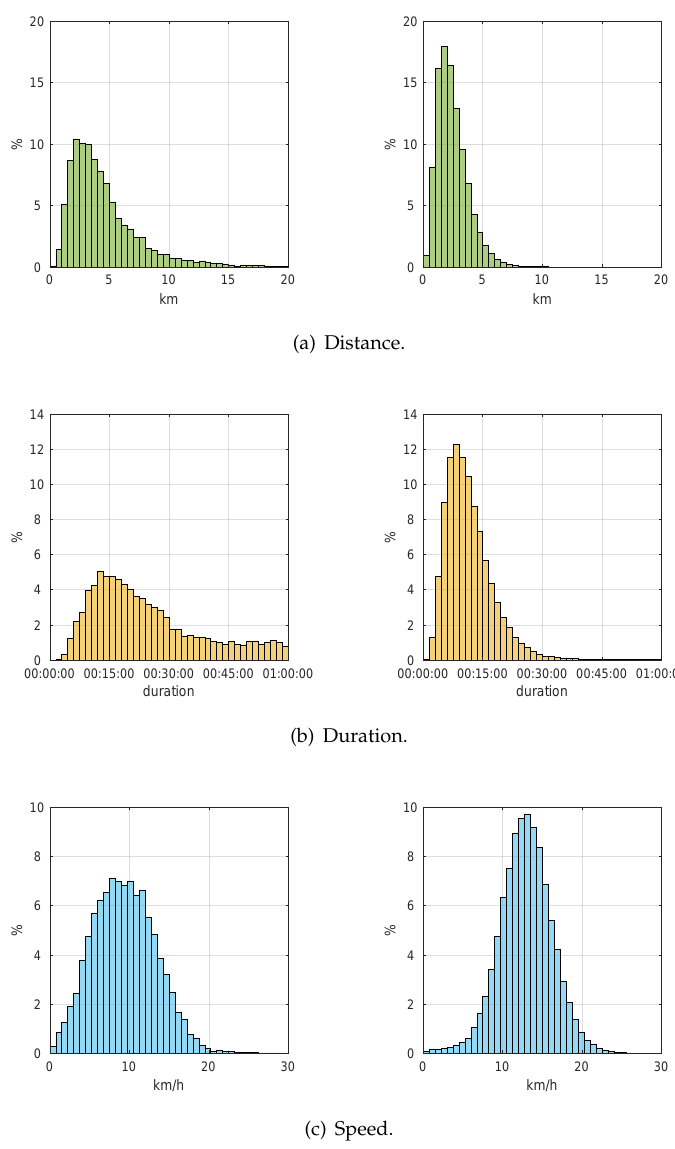
Figure 3. Statistical characterization of trips: leisure ( α p < α ∗ ) on the left, and transport ( α p ≥ α ∗ ) on the